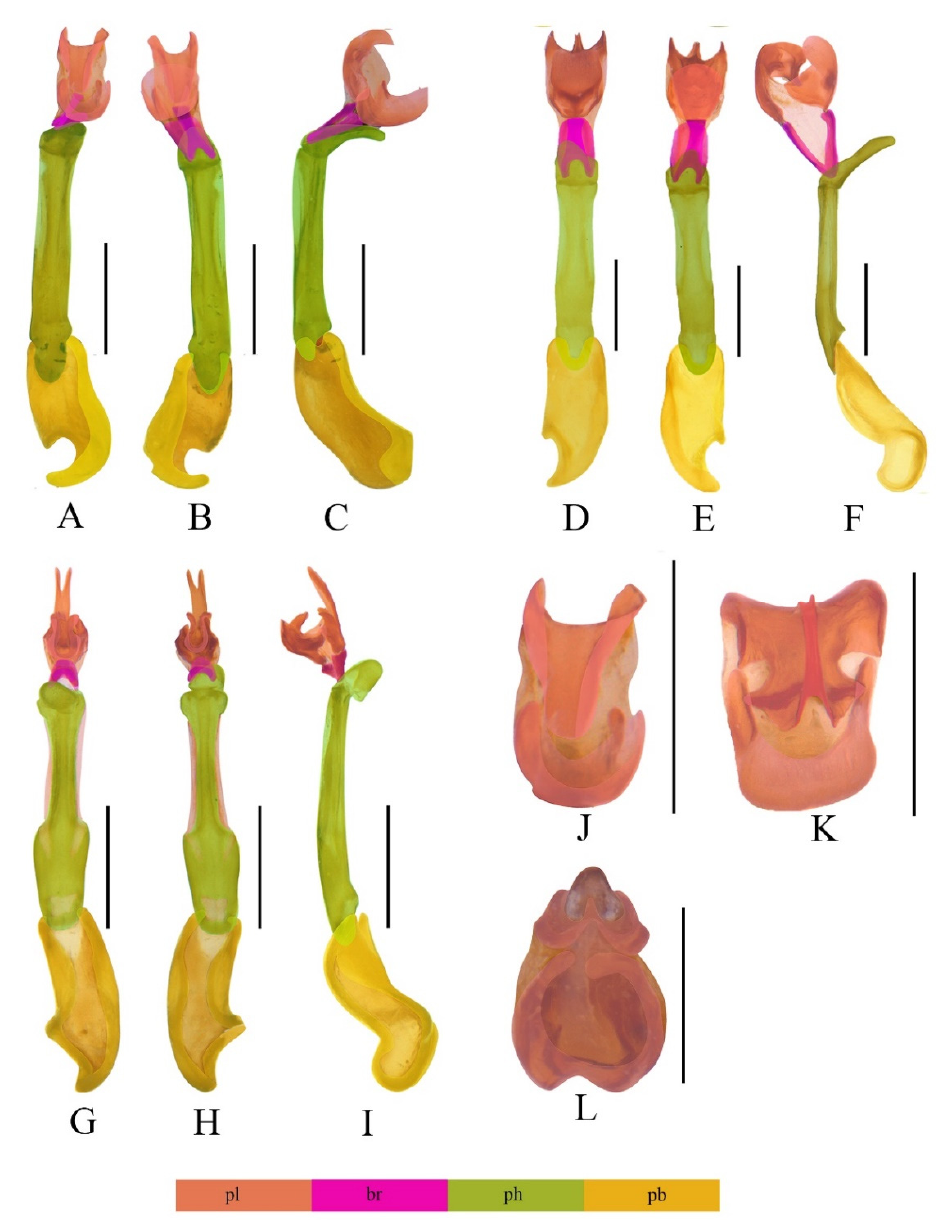
Figure 3. Aedeagi of Mesolycus species: ( A – C , J ). M . varus sp. n.; ( D – F , K ). M. breviplatus sp. n.; ( G – I , L ). M . murzini Kazantsev, 2004. ( A , D , G )—ventrally; ( B , E , H )—dorsally; ( C , F , I )—laterally; ( J – L )—apically. Scales: ( A – I , K ), 0.5 mm; ( J , L ), 0.2 mm. pl—plate; br—basal rods; ph—phallus; pb—phallobase. Female. Similar to male, but antennae close to